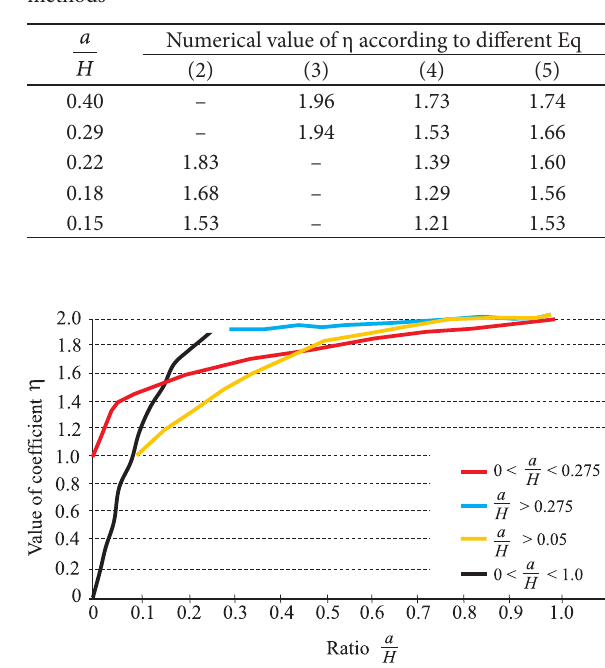
Fig. 1. Specimen’s types, where L – length; B – width; H – hight,